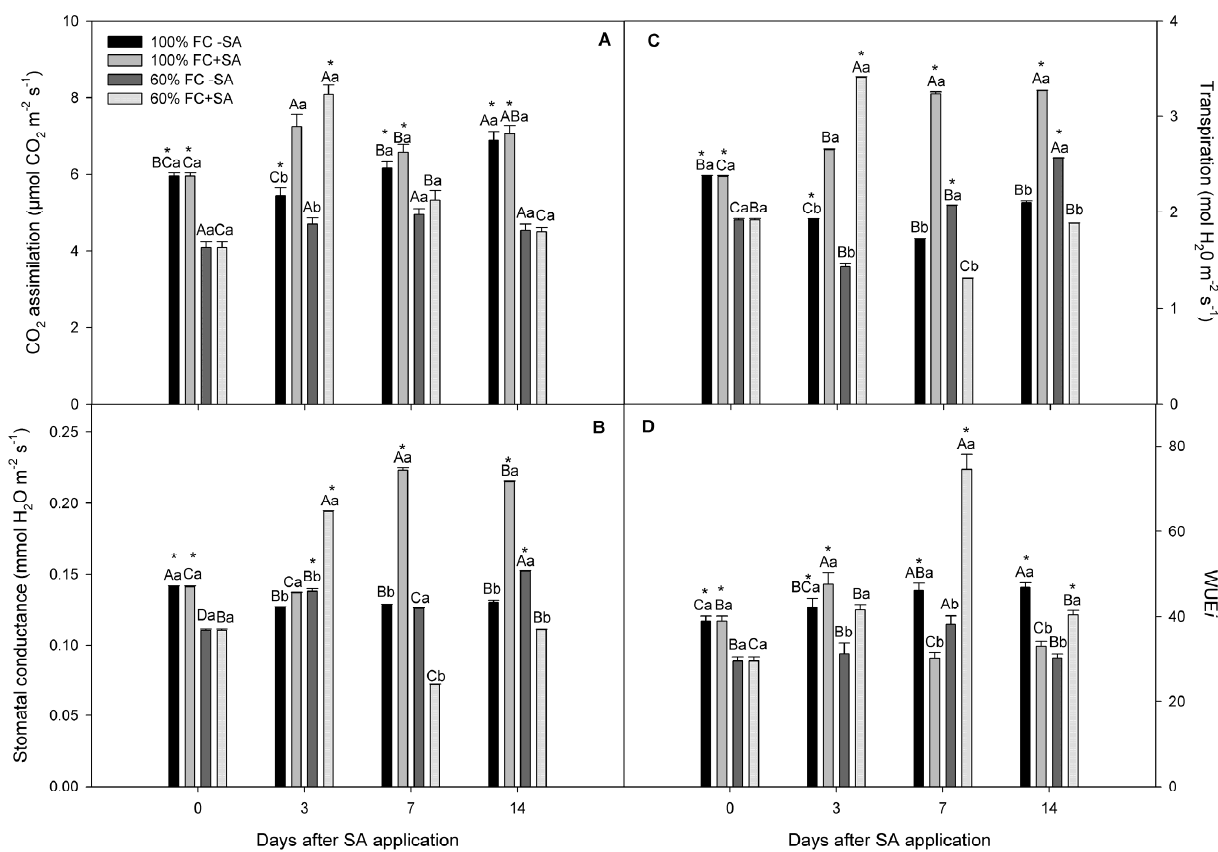
Figure 3. Gas-exchange measurements in A. chilensis plants grown under 100% and 60% FC and two SA doses (0 and 0.5 mM) at different times. ( A ) CO 2 assimilation, ( B ) stomatal conductance, ( C ) transpiration, and ( D ) intrinsic water-use efficiency (WUE i ). The bars are means ± SE ( n = 3). Different uppercase letters indicate significant differences among days for the same SA and irrigation treatment according to Tukey’s test ( p ≤ 0.05). Different lowercase letters indicate significant differences between SA treatment for the same irrigation treatment and time post SA application according to Tukey’s test ( p ≤ 0.05). According to Tukey’s test, asterisks indicate significant differences between ( p ≤